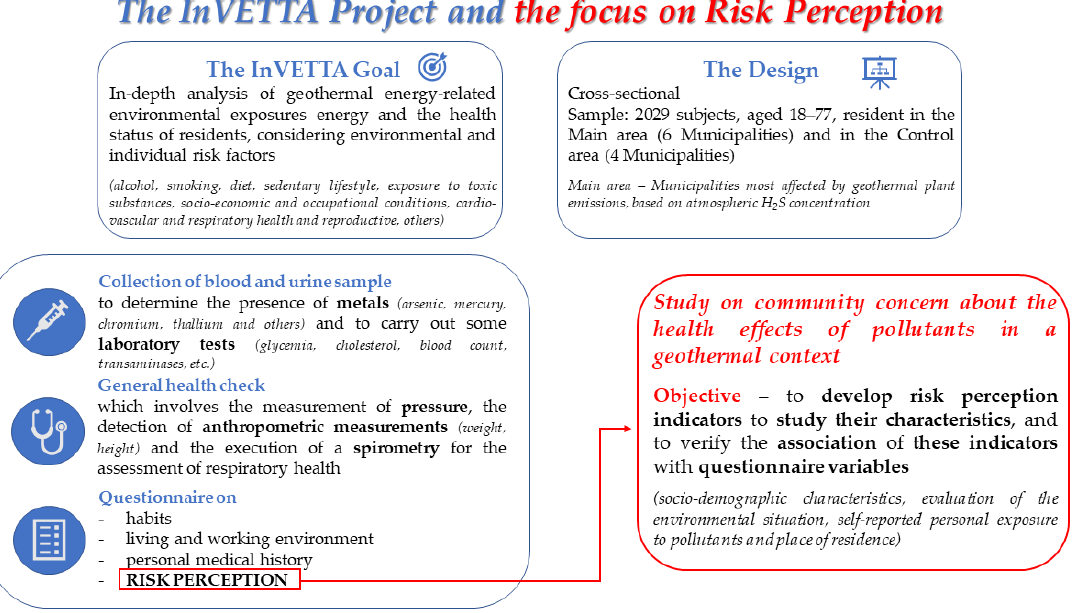
Figure 2. Scheme of the InVETTA project and how our study fits within the InVETTA project.